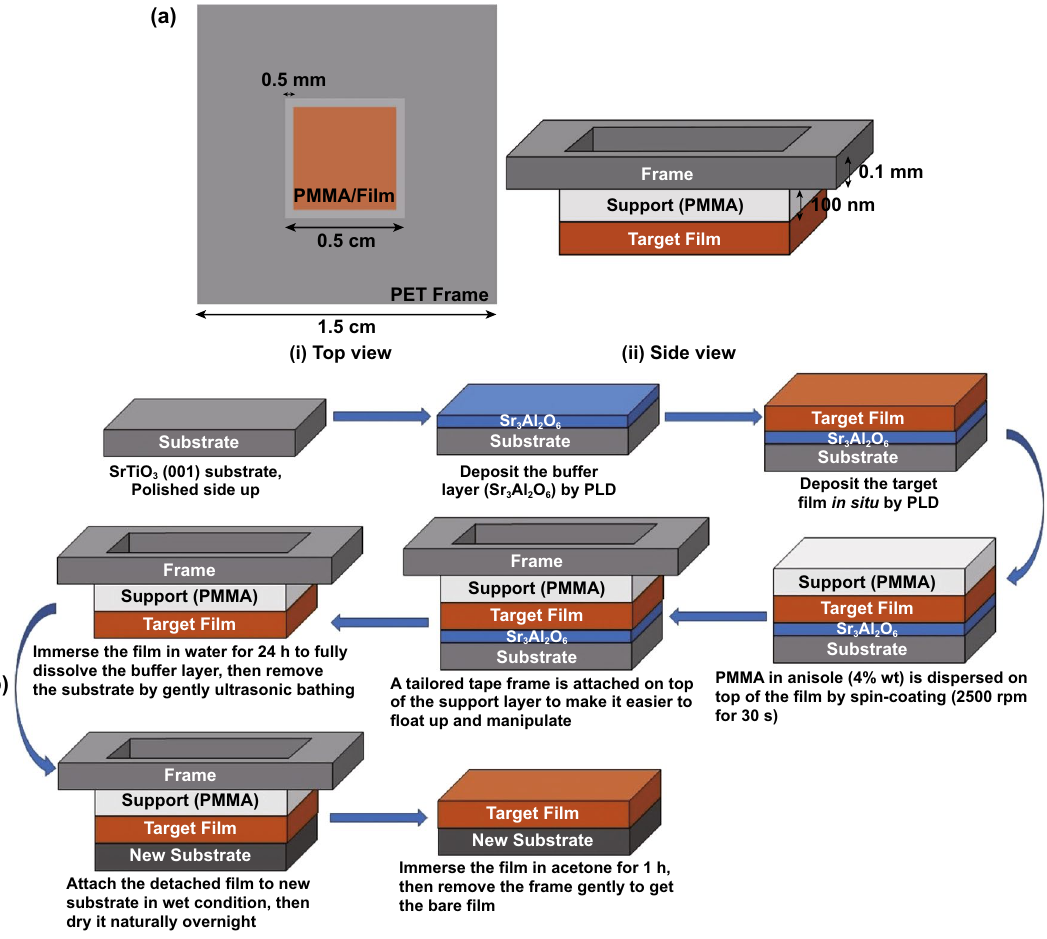
Fig. 2 Schematic of PET frame on PMMA support for lifting off and placing a film on a new substrate. a Placement of PET frame on PMMA support. (i) Top view. (ii) Side view; b schematic of the whole process developed in this work based on method IV in Fig.